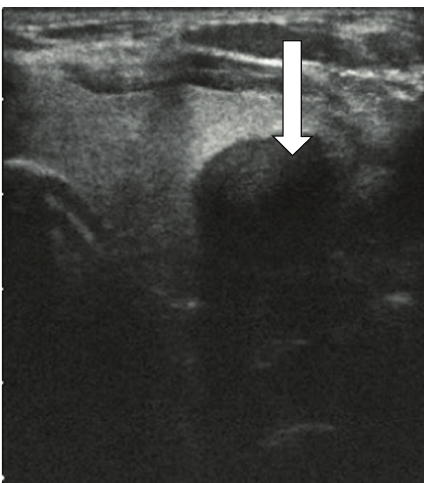
Figure 1: Ultrasonography showing a heterogeneously hypoechoic giant mass with undetermined inferior